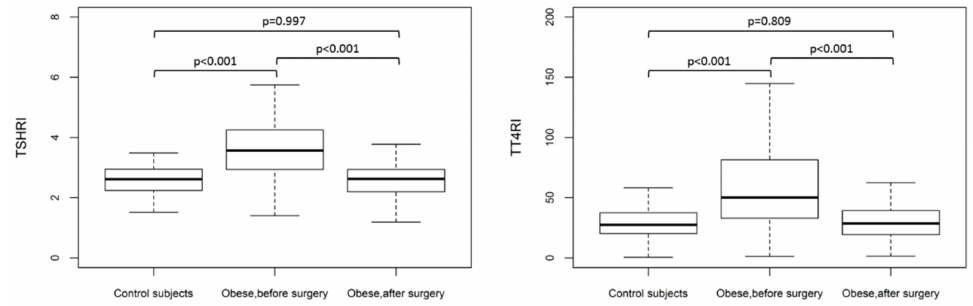
Figure 1. Thyrotroph T4 resistance index (TT4RI) and TSH index (TSHRI) values (Median (IR)) in control subjects ( n = 38) and obese patients ( n = 106) before and 12 months after surgery.